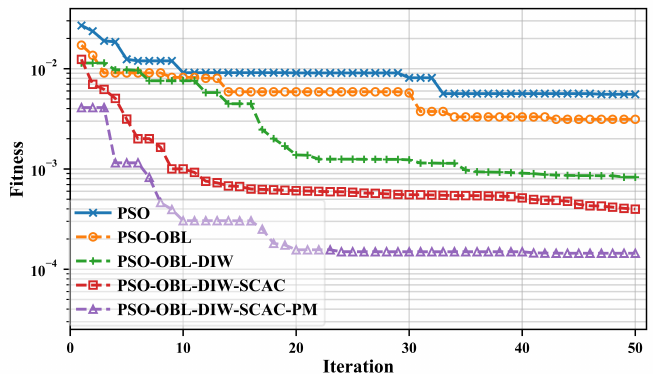
Figure 5. Comparison of the optimization process of different strategies in the three-layer geoelectric model test. The number of evolutionary iterations is 50. The blue line represents the optimization process of traditional PSO. The orange line represents the optimization process of PSO-opposition- based learning (OBL). The green line represents the optimization process of PSO-OBL-dynamic inertia weight (DIW). The red line represents the optimization process of PSO-OBL-DIW-sine-cosine acceleration coefficient (SCAC). The violet line represents the optimization process of PSO-OBL-DIW- SCAC-population mutation